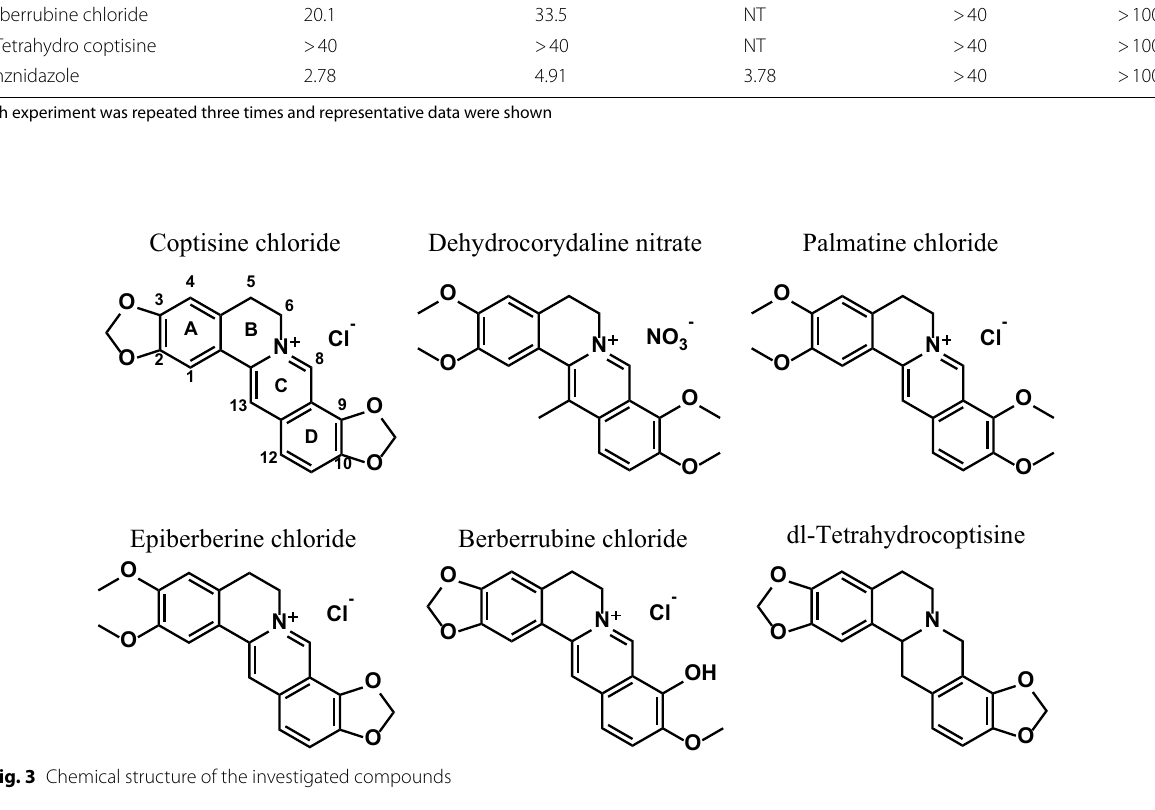
Fig. 3 Chemical structure of the investigated